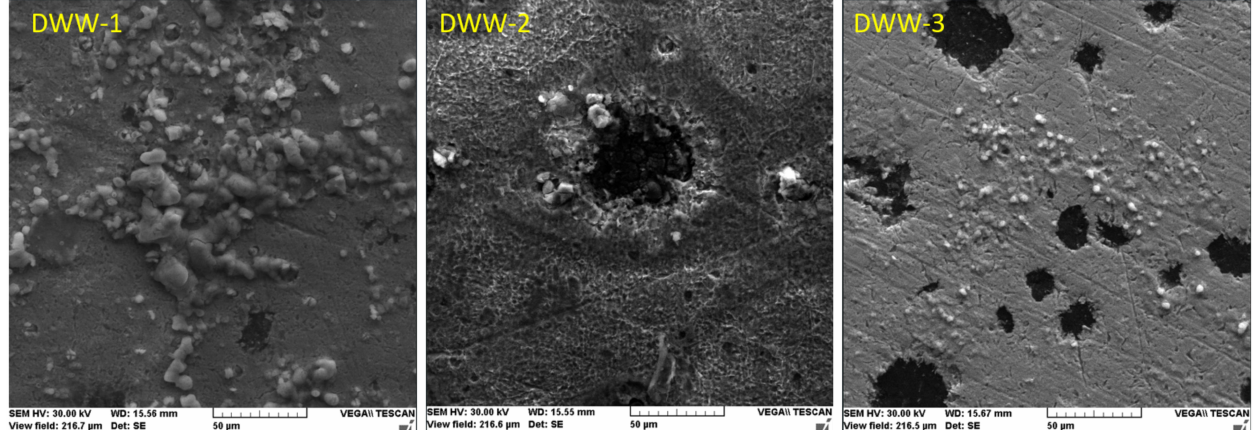
Figure 6. Microphotographs of samples immersed for 1 h, after recording the polarization curves and electrochemical impedance spectra, in the used corrosive